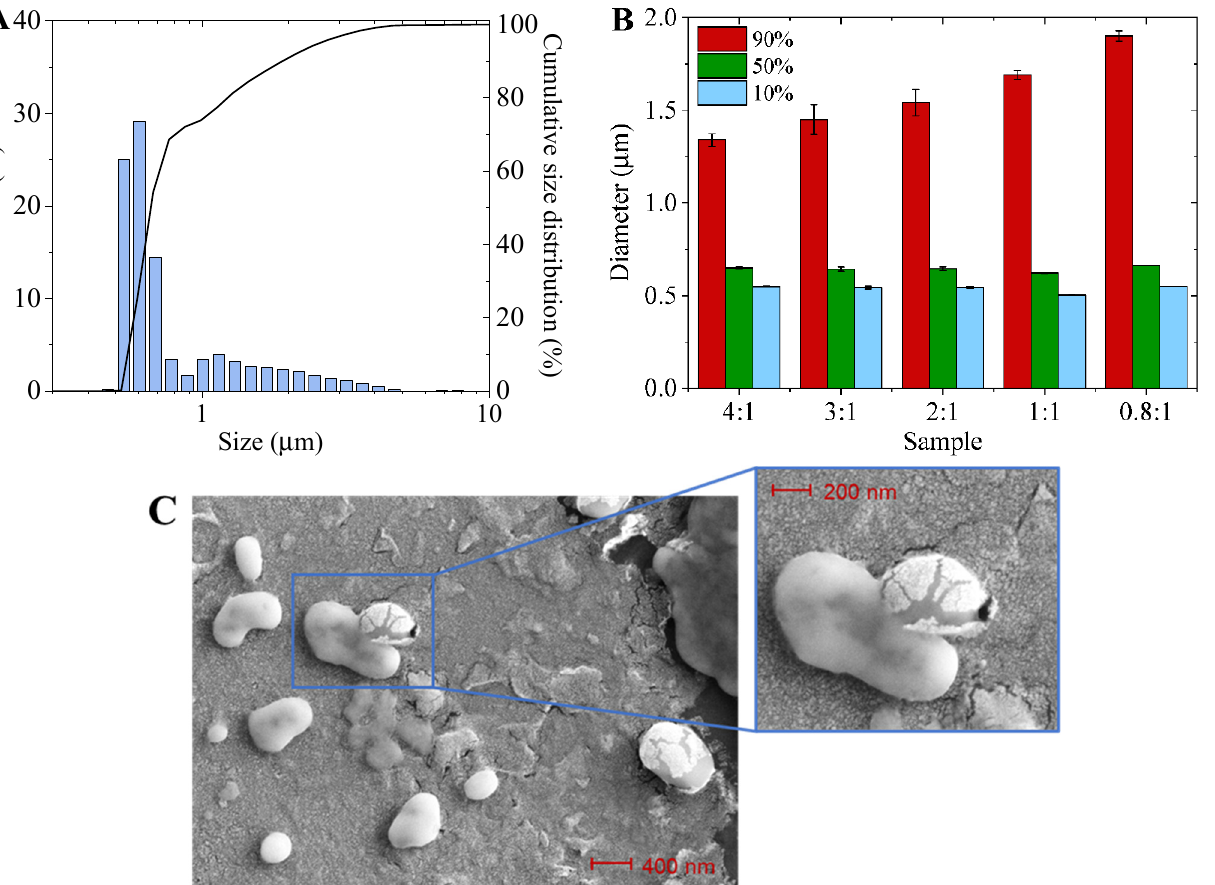
Figure 4. ( A ) size distribution of the generated LMCs for the sample 0.8:1; ( B ) percentage of LMCs falling below a specific diameter value (90%, red bars, 50% green bars, 10% light blue bars); ( C ) FE-SEM micrographs of LMCs prepared with a 0.8:1 SLS to limonene ratio.